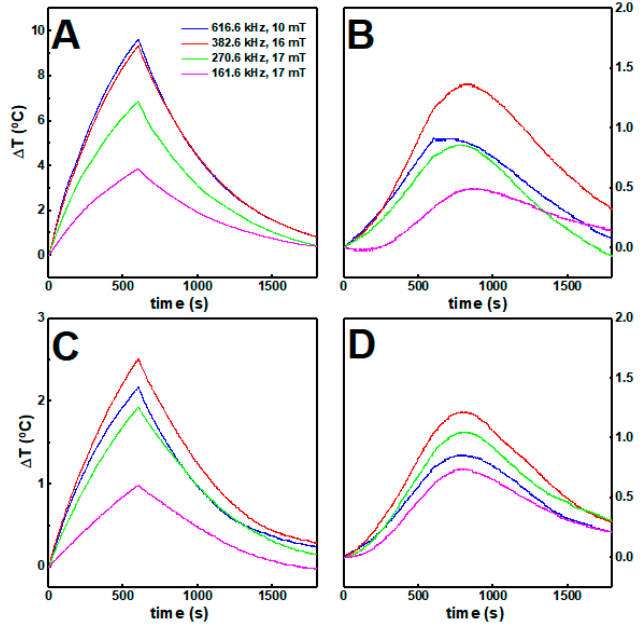
Figure 7. The temperature variation over time of ( A ) citrate-stabilized and ( B ) lipid-coated nanoparticles at 1 mg/mL (0.1 wt%) in water and in gels ( C , D ) respectively) under different magnetic field strengths and frequencies.